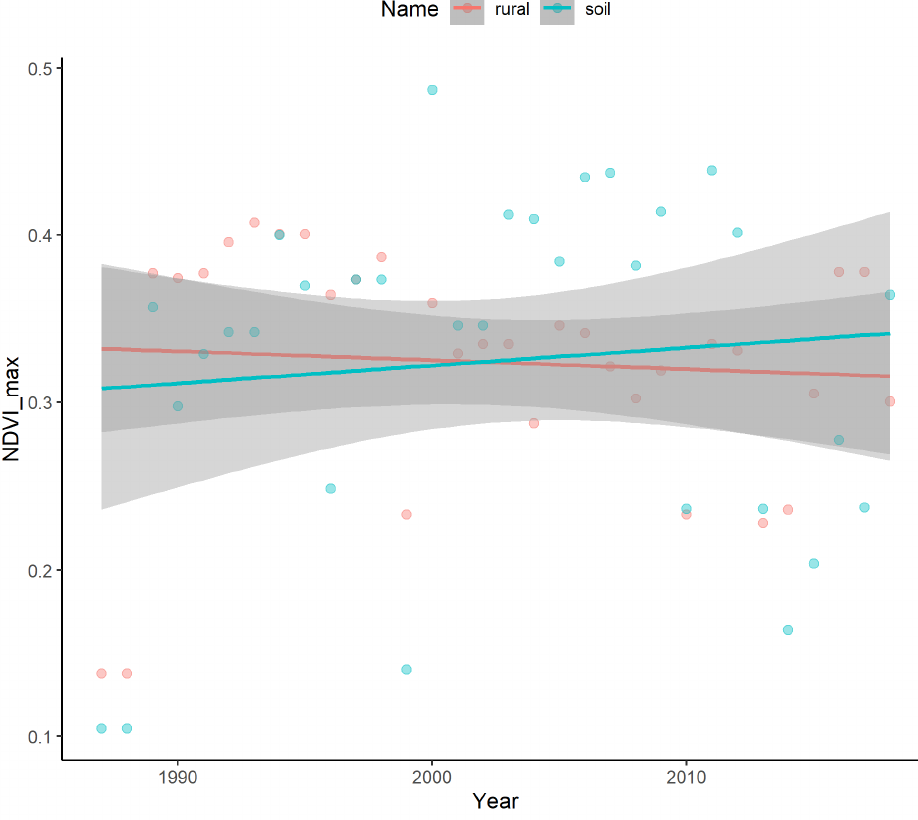
Figure 4. The annual NDVI_max linear fitting model for rural settlement sample and bare soil.